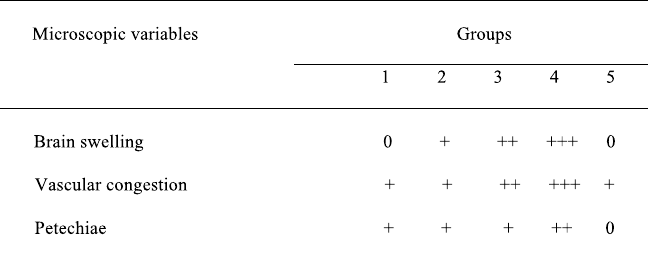
TABLE 1 - Analysis of subjective microscopic variables in traumatic brain injury with increased levels of impact energy for closed head